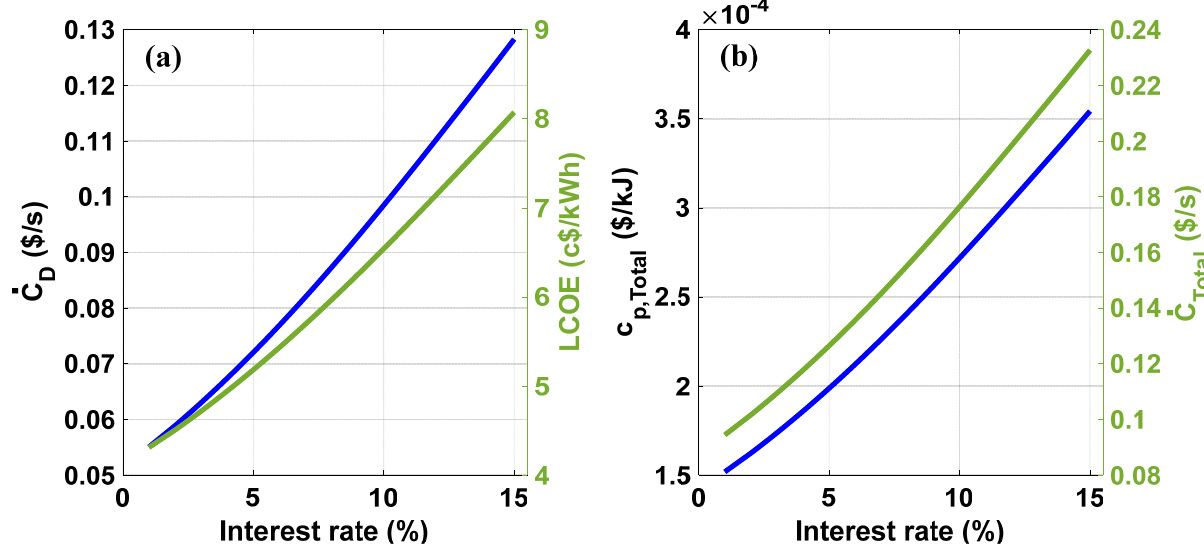
Figure 9. ( a ) Exergy destruction cost and levelized cost of energy variations against interest rate. ( b ) Production and total cost rate variations against interest rate.